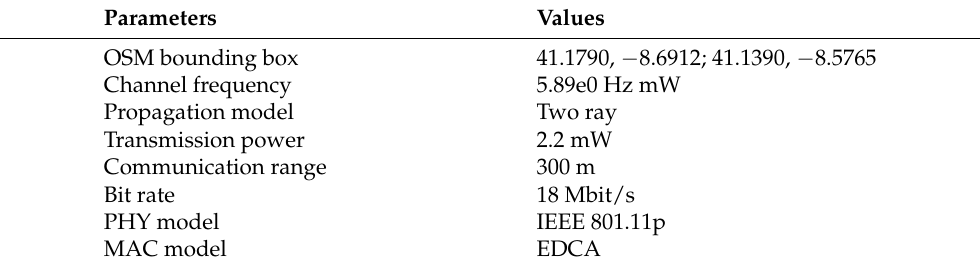
Table 1. Simulation